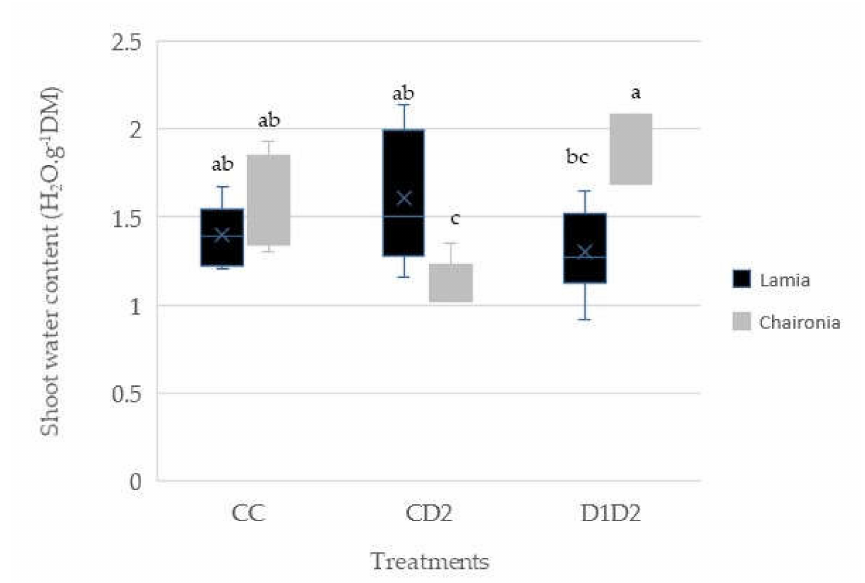
Figure 4. Shoot water content expressed as g of water per g of dry shoot weight. Bars show the mean of the biological replicates ± SE on day 133; lower case letters indicate significant di ff erences between the means ( p < 0.05).